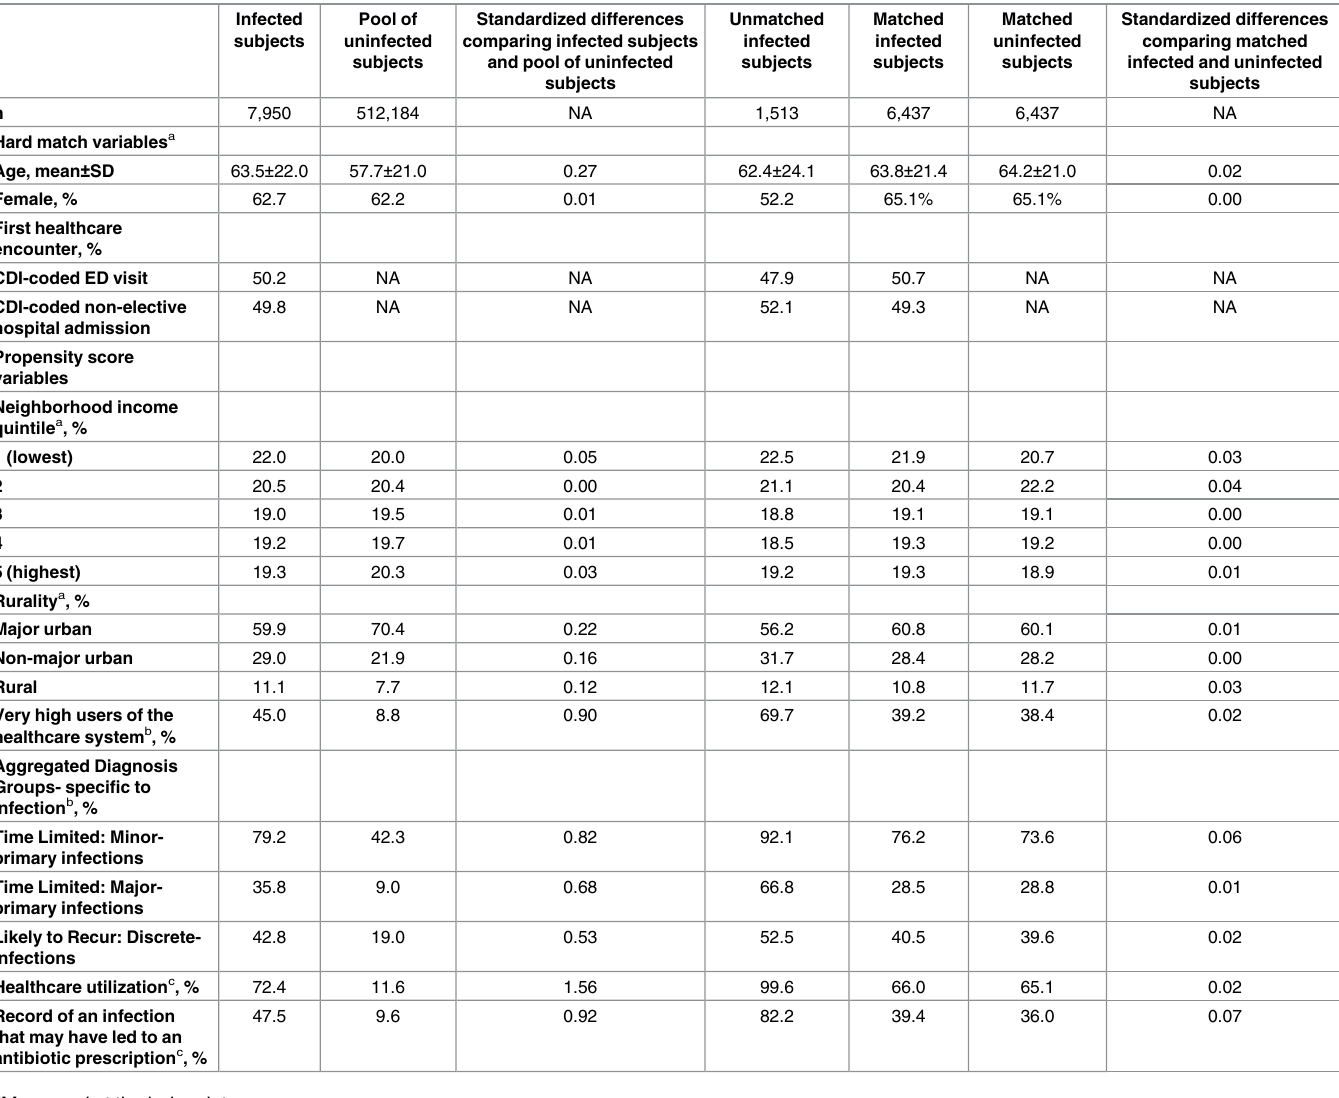
Table 2. Selected characteristics of those with community-onset CDI before and after